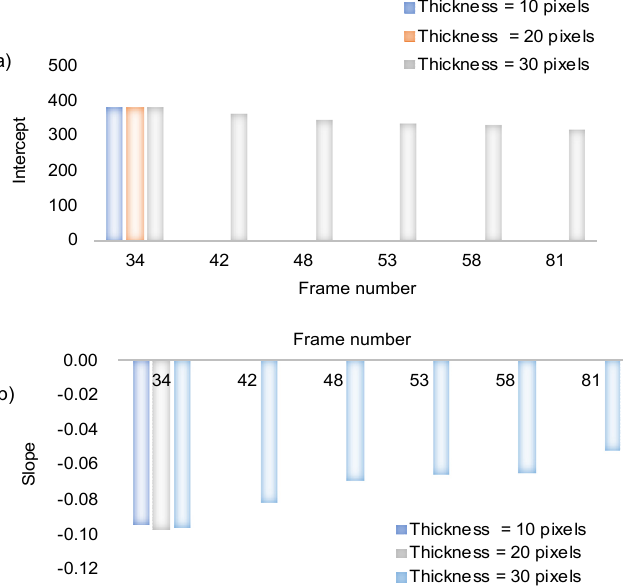
Figure A1. Box sensitivity analysis for deep aponeurosis ( a ) Slope of bottom boundary of fascicle band for different thickness of the box around deep aponeurosis and ( b ) Intercept of bottom boundary of fascicle band for different thickness of the box around deep aponeurosis.